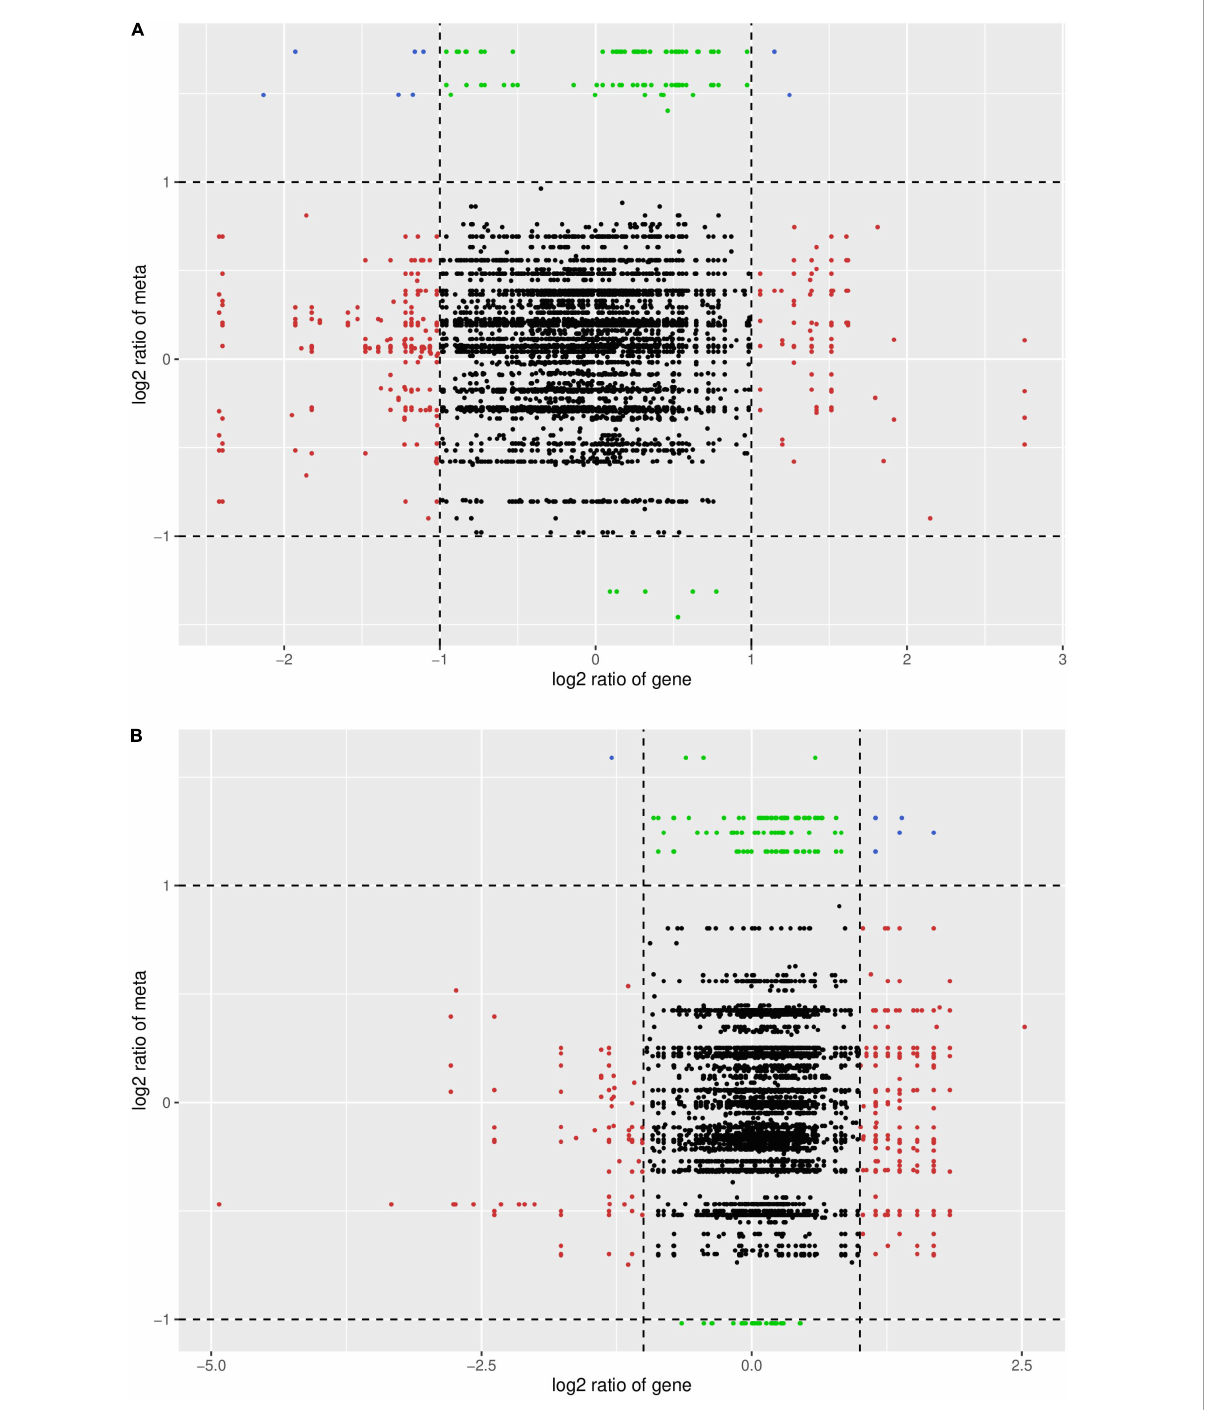
FIGURE13 Nine-quadrant plot of correlation between DAMs and DEGs. The abscissa represents the log2FC of genes, and the ordinate represents the log2FC of metabolites. The 1st, 2nd, and 4th quadrants indicate that metabolites are expressed at higher levels than genes; the 3rd and 7th quadrants indicate that the differential expression patterns of genes and metabolites are consistent; the 5th quadrant indicates that neither genes nor metabolites are differentially expressed; The 9th quadrant indicates that metabolites are expressed in lower abundance than genes. (A) HN44 group; (B) HN65